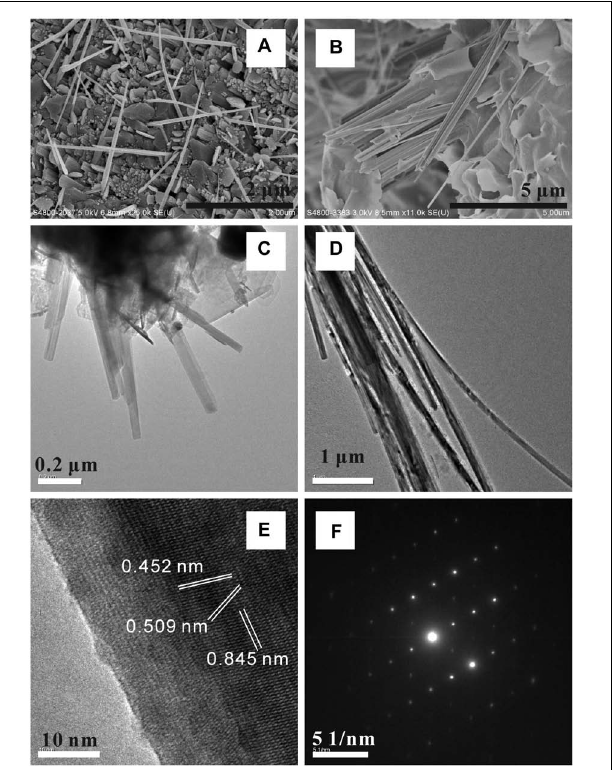
FIGURE 11 | SEM and TEM characterizations of actinolite fiber bundles formed in [H 2 O-CO 2 ]-komatiite system (A,C) and [H 2 O-CO 2 ]-peridotite system (B,D) . (E) HRTEM image of the crystal showing clear lattice fringes. The measured spacings of the crystallographic planes are 0.845, 0.509, and 0.452 nm, respectively. (F) SAED pattern of one single actinolite